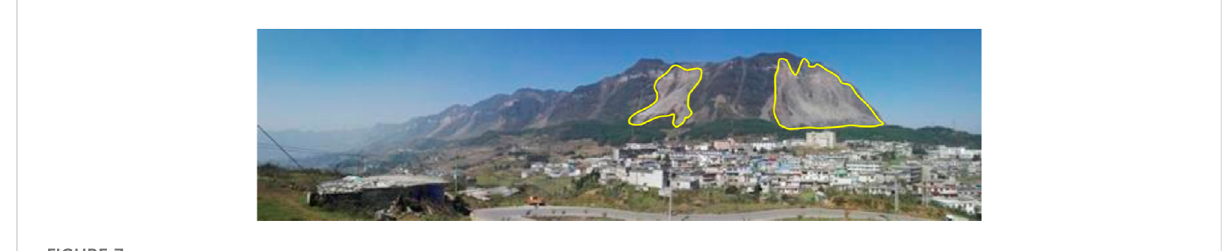
FIGURE 6 Field visit photographs of Shiping village.